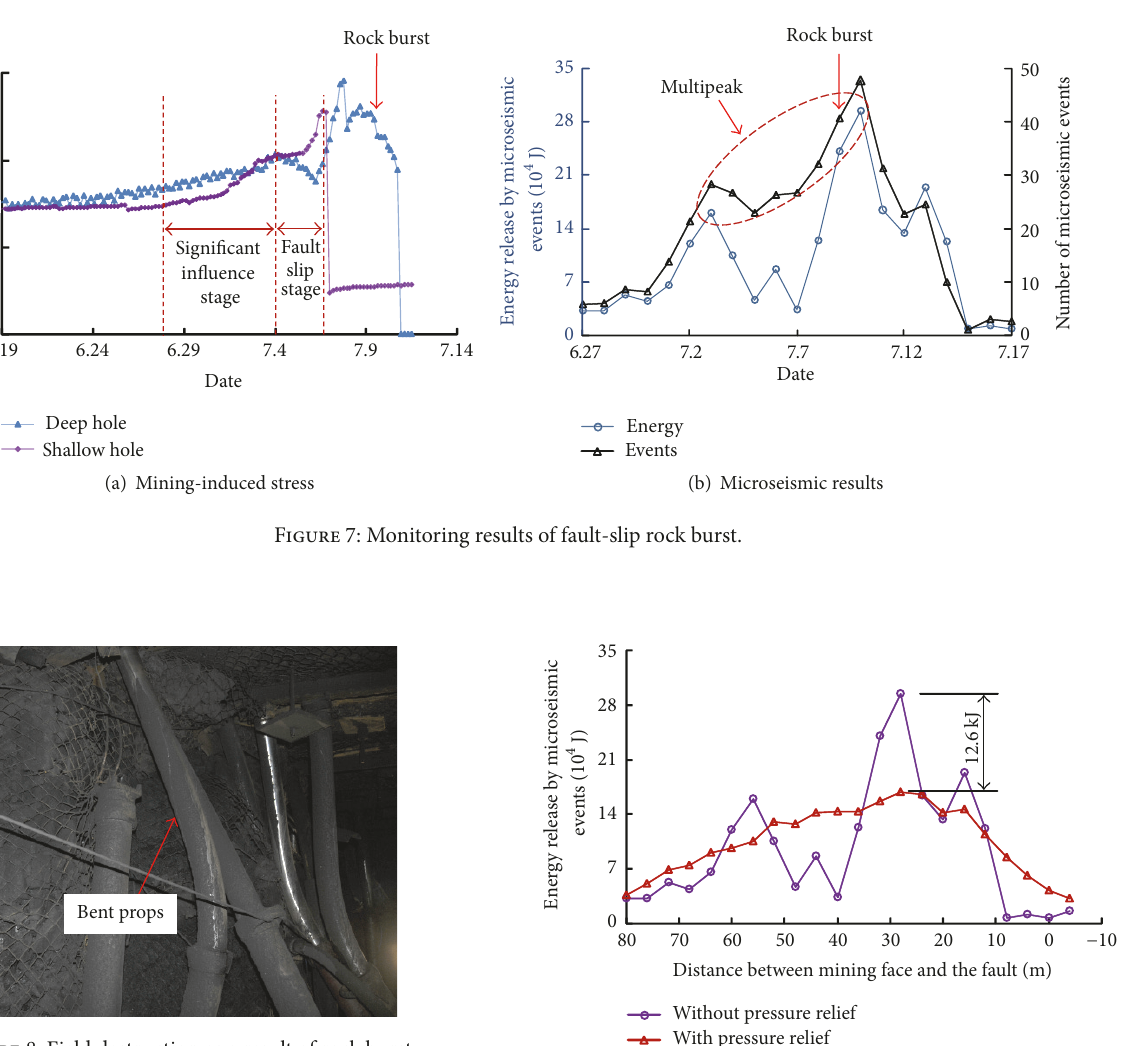
Figure 8: Field destruction as a result of rock burst.